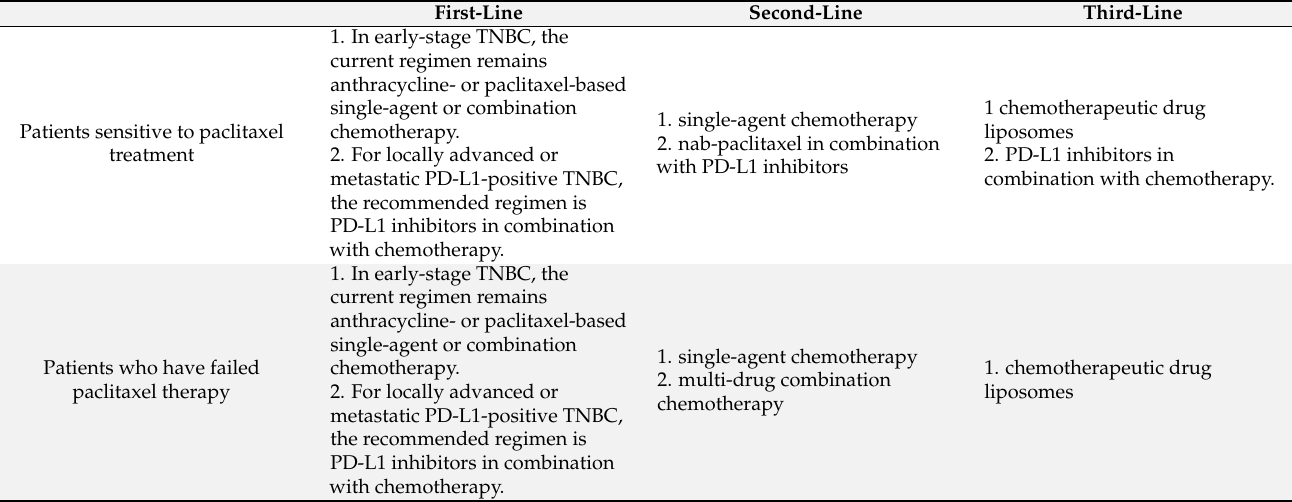
Table 7. The current standard of care for